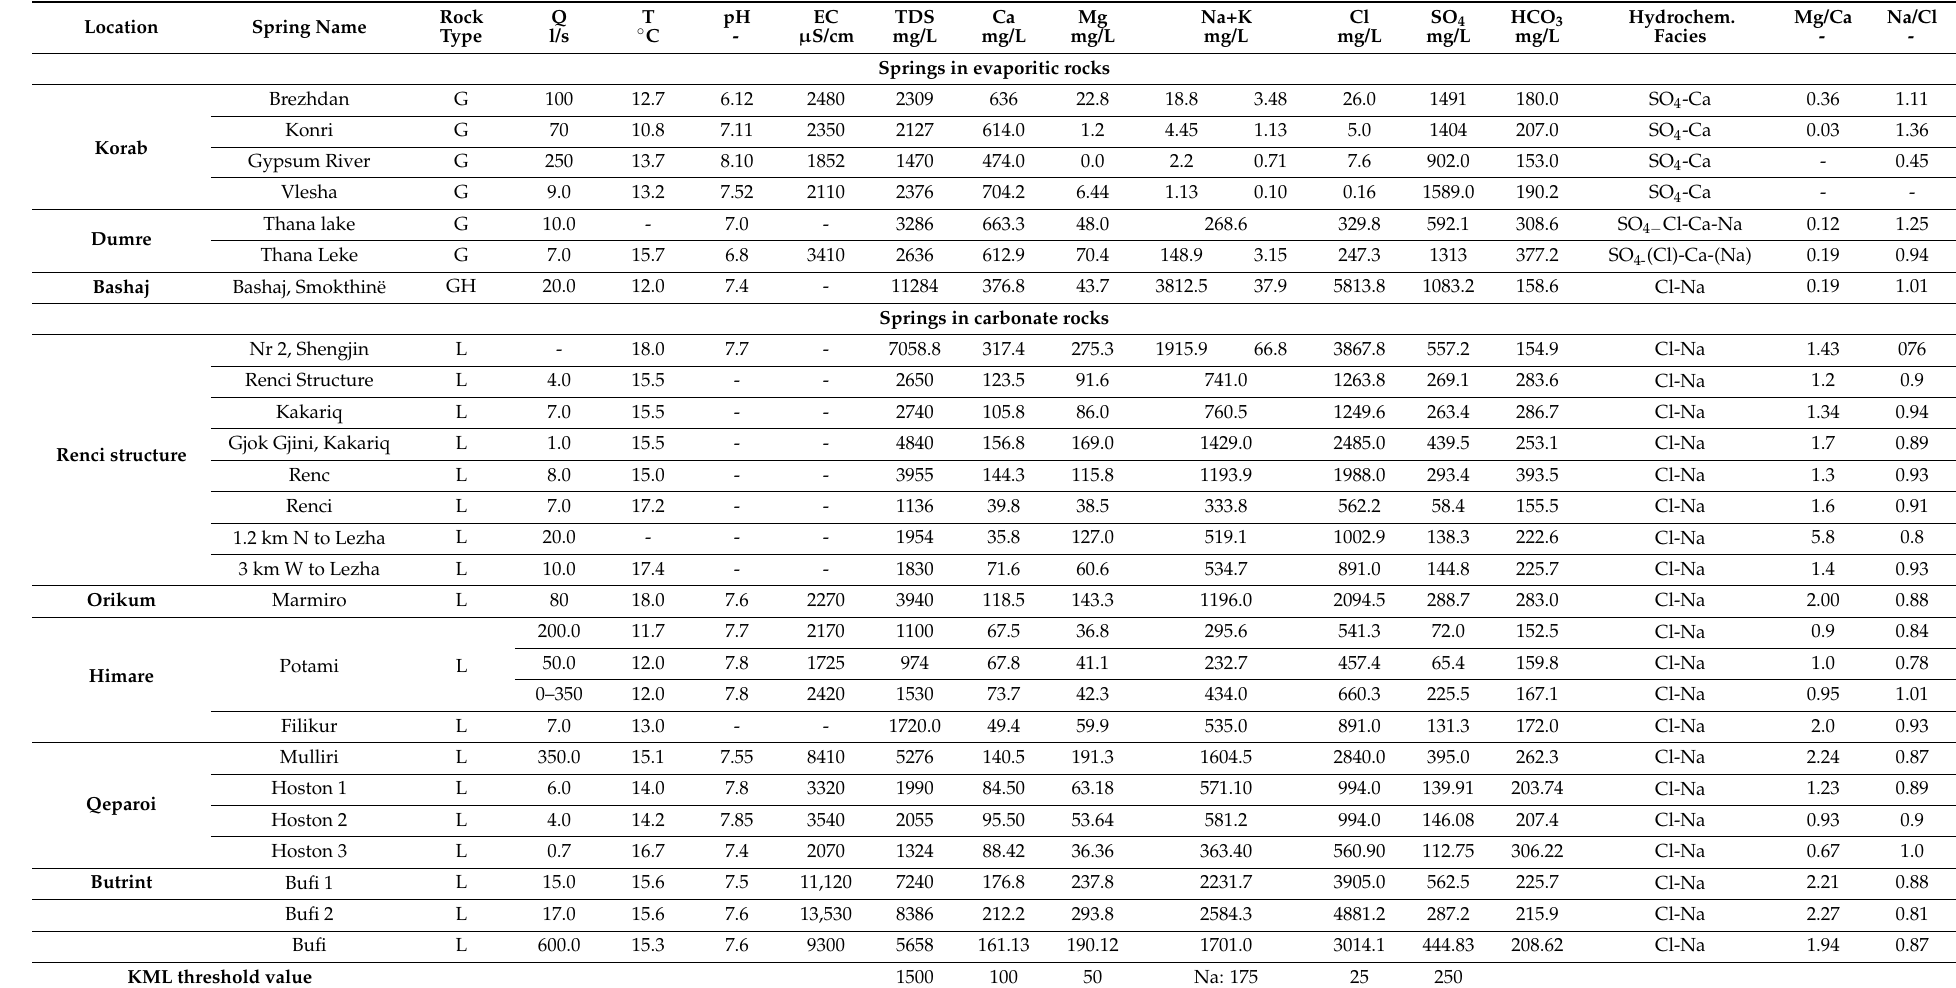
Table 1. Main Albanian cold brackish springs parameters. Analyses conducted by the Hydrochemical Laboratory of the former Hydrogeological Enterprise (Tirana) and the Hydrochemical Laboratory of Silezia University (Poland) [34]. Rock type: G, gypsum; H, halite; L, limestone; Q, discharge; T, temperature; EC, electrical